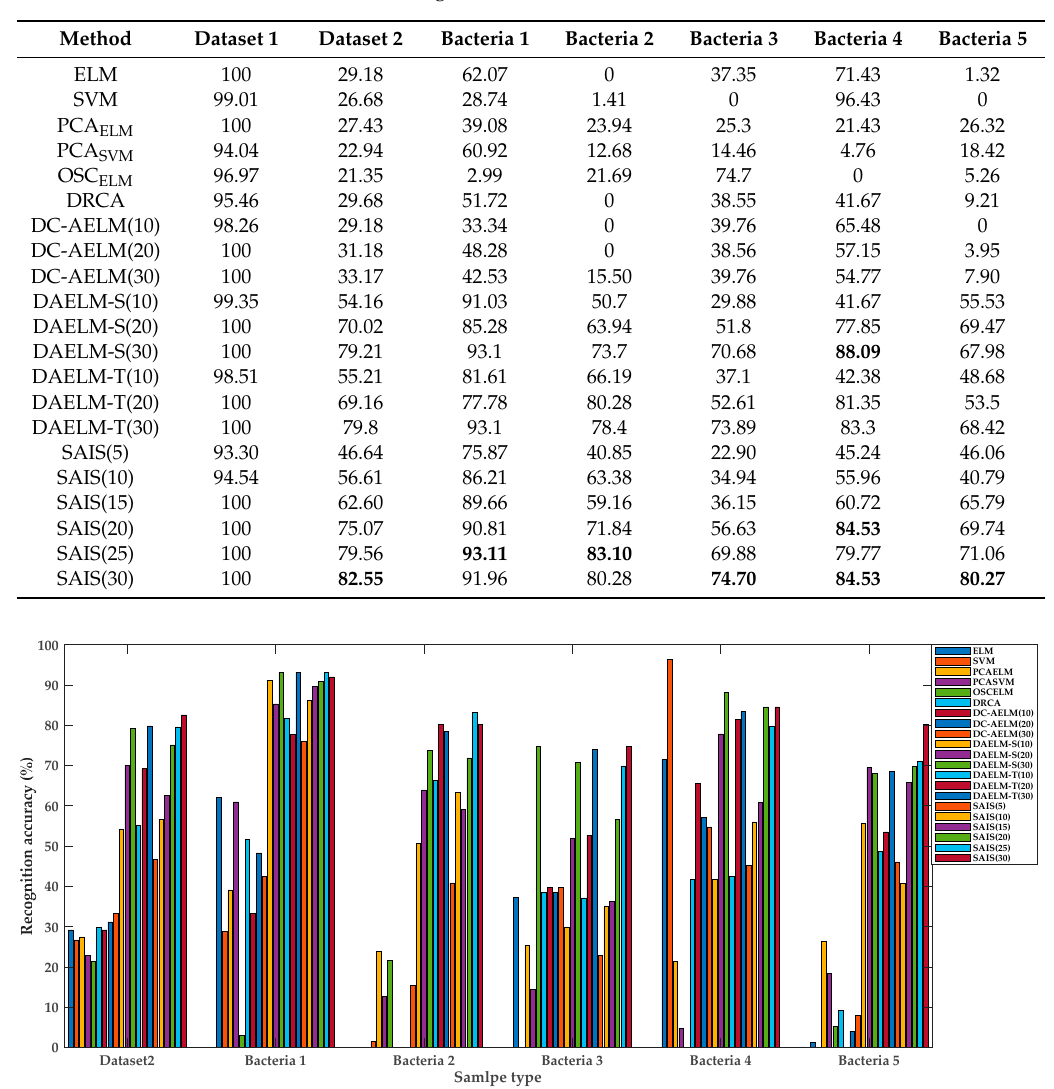
Figure 7. Comparisons of different methods for each bacterium.